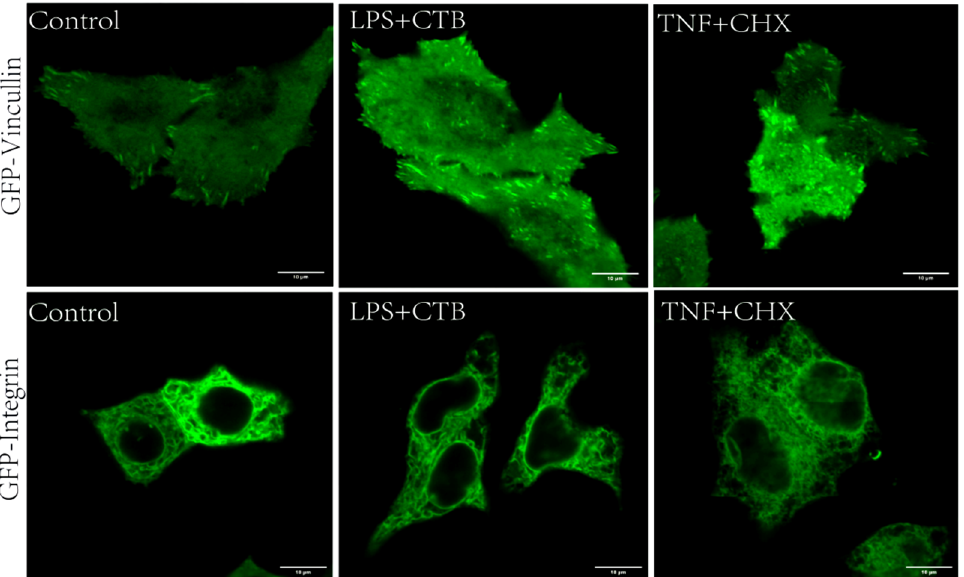
Figure 4. The expressions of integrin and vinculin in pyroptosis and apoptosis. HeLa cells were transfected with GFP-vinculin and GFP-integrin constructs. The upper row depicted the vinculin expressions in control group in response to LPS and CTB, TNF, and CHX stimulations. The lower row depicted the integrin expressions in control group in response to LPS and CTB, TNF, and CHX stimulations.